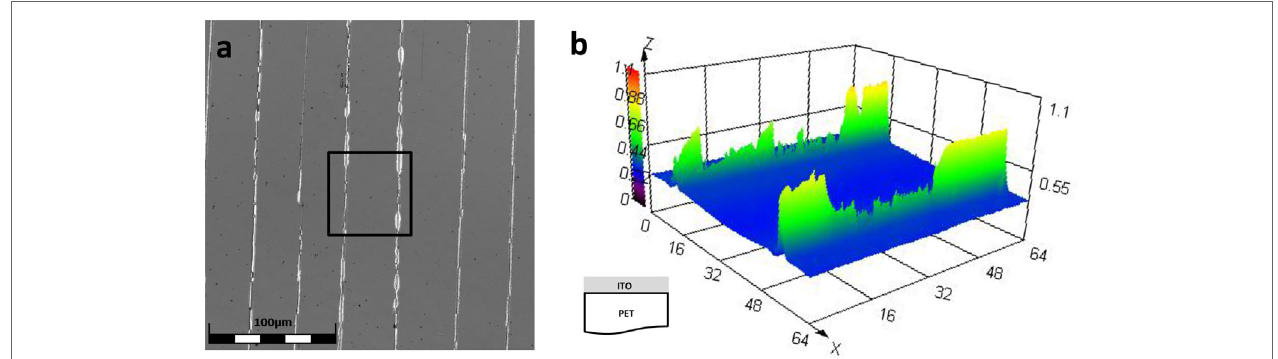
FigUre 2 | (a) CLSM laser image of 100-nm ITO film on PET after mechanical testing. (B) Color 3D height image of the box in (a) demonstrating the capabilities of CLSM with transparent conductors. The units in (B) are in microns (color